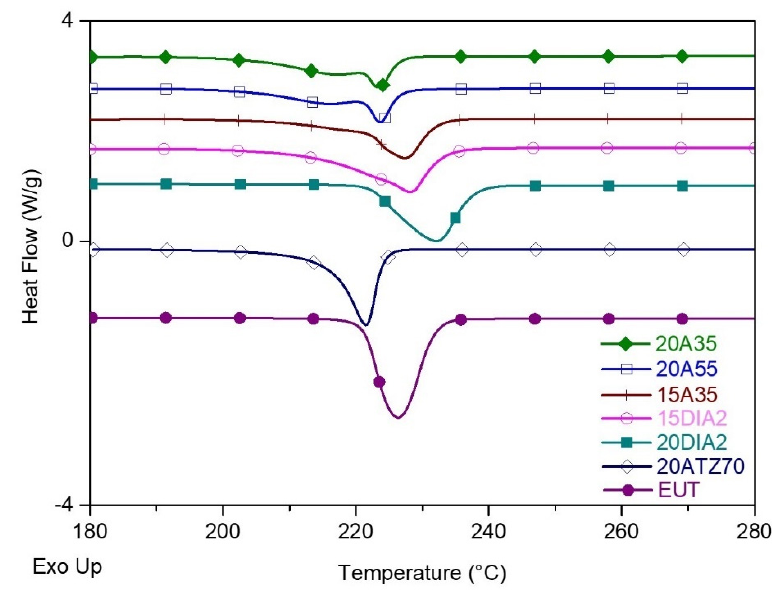
Figure 4. DSC curves around the melting peaks at the 2nd thermal cycle of the SSPCM samples.